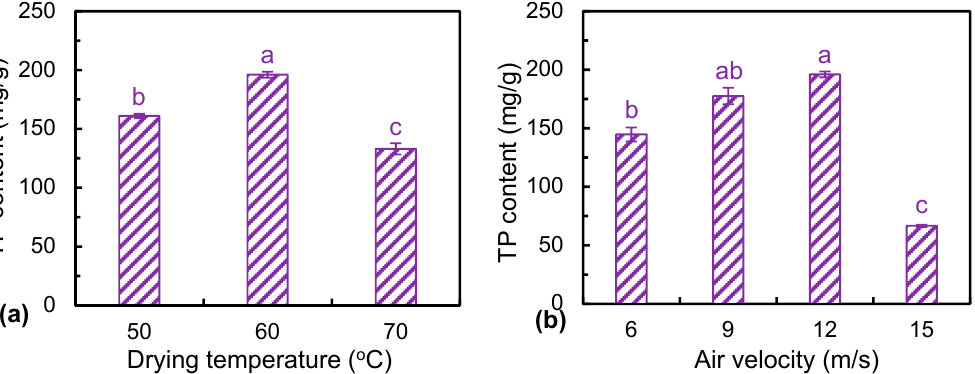
Figure 4. Total polysaccharide content of dried Ophiopogonis Radix under different drying tempera- tures ( a ) and air velocities ( b ). Different letters (a–c) indicate the significant differences at p < 0.05.